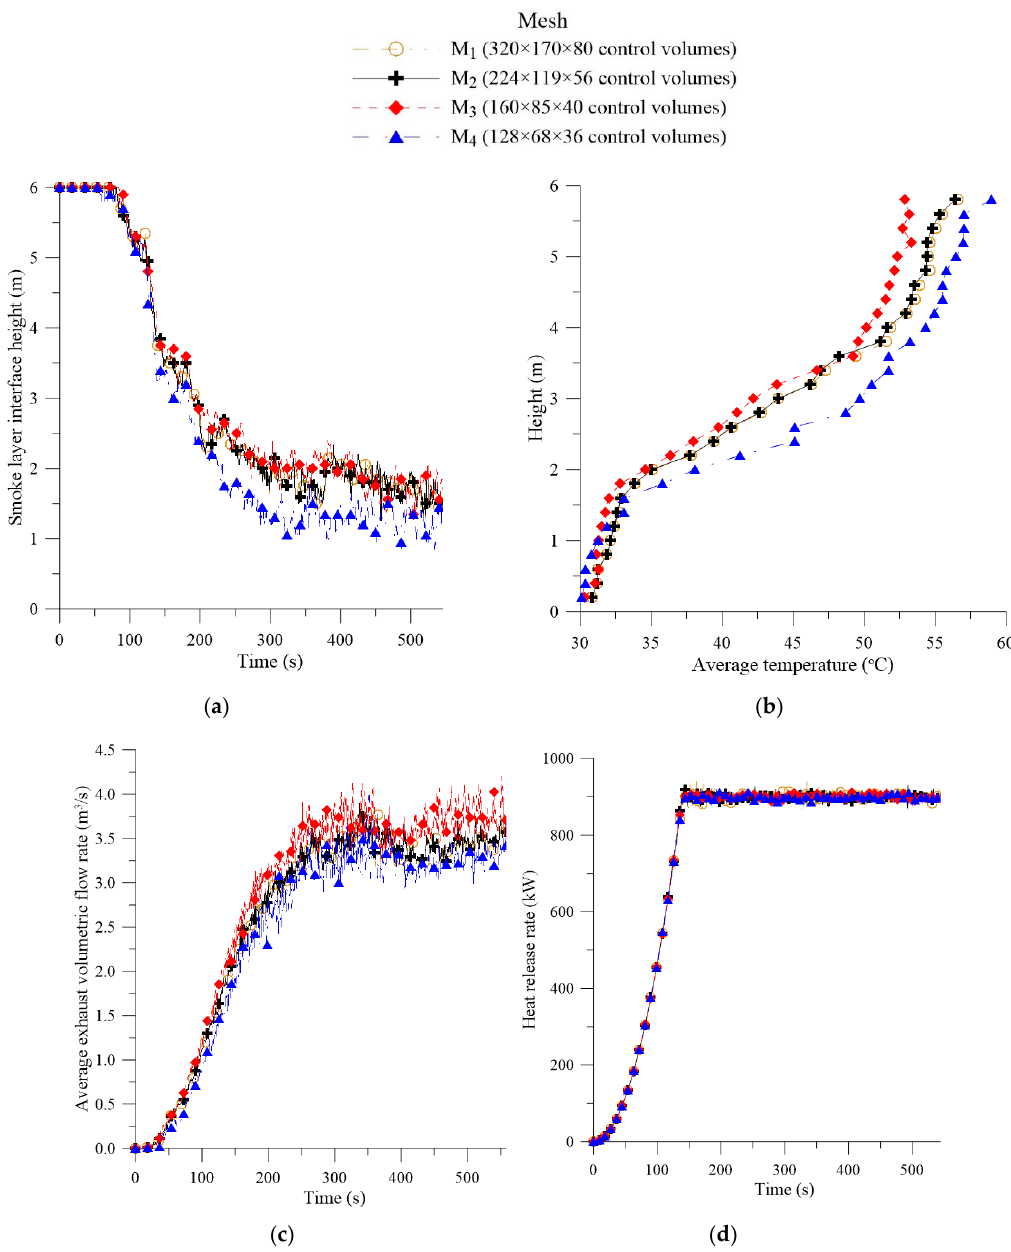
Figure 5. Mesh convergence analysis for case 6: ( a ) smoke layer displacement; ( b ) average temperature profile at t = 600 s; ( c ) average exhaust volumetric flow rate and ( d ) HRR.